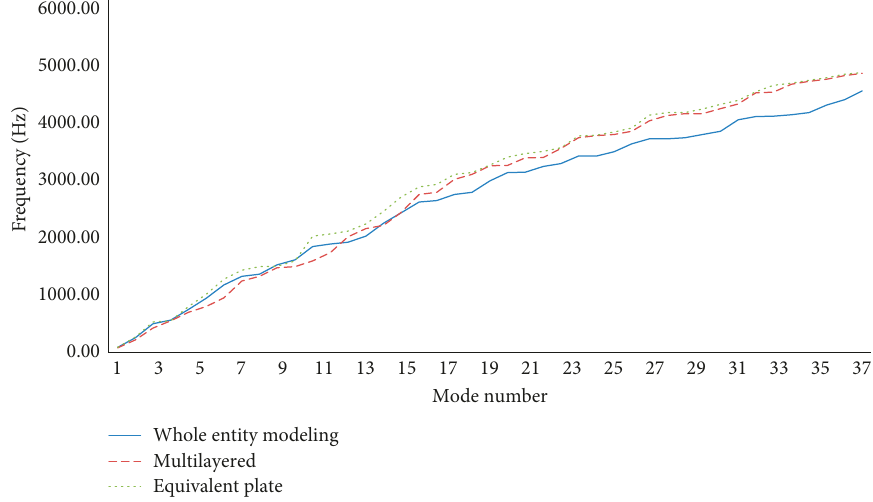
Figure 10: Comparison of models for large frequency range.